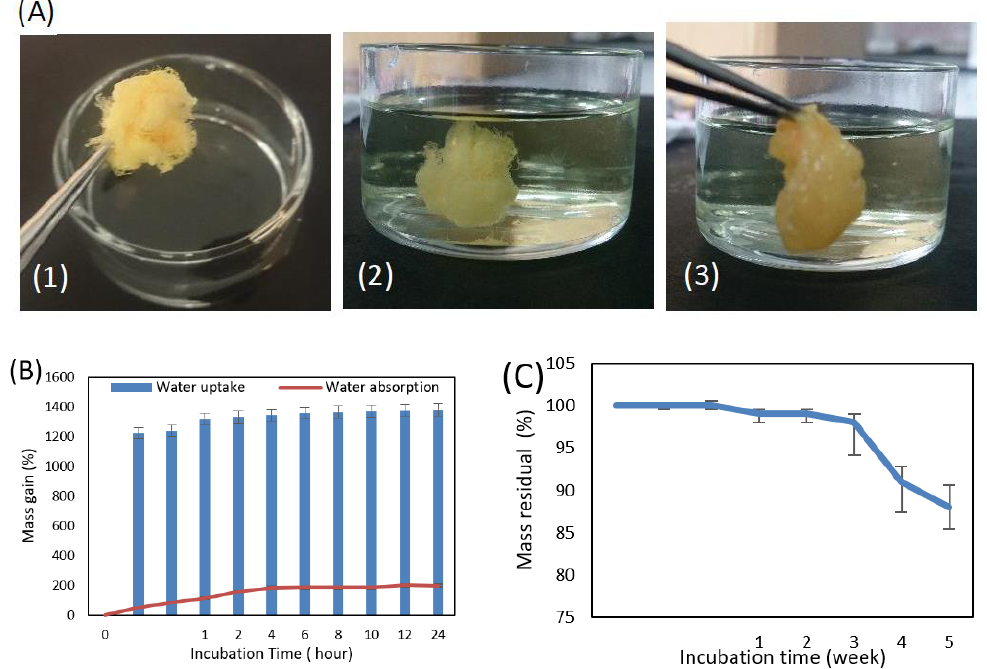
Figure 6. Water absorption behavior (hydration degree) of the 3D fibrous structure of collagen-g-poly(MMA-co-EA)/N6 formed by coaxial electrospinning at 12 kV applied voltage: ( A ) The feature of a sample before immersion in water (dry) (1), in the water after 24 h (2) and out of the water after 24 h (wet) (3). ( B ) Water absorption (hydration degree) and water uptake of samples ( n = 5, p < 0.01) in percentage within 24 h. ( C ) Mass residual percentage of the samples ( n = 5, p < 0.005) in PBS vs. incubation time